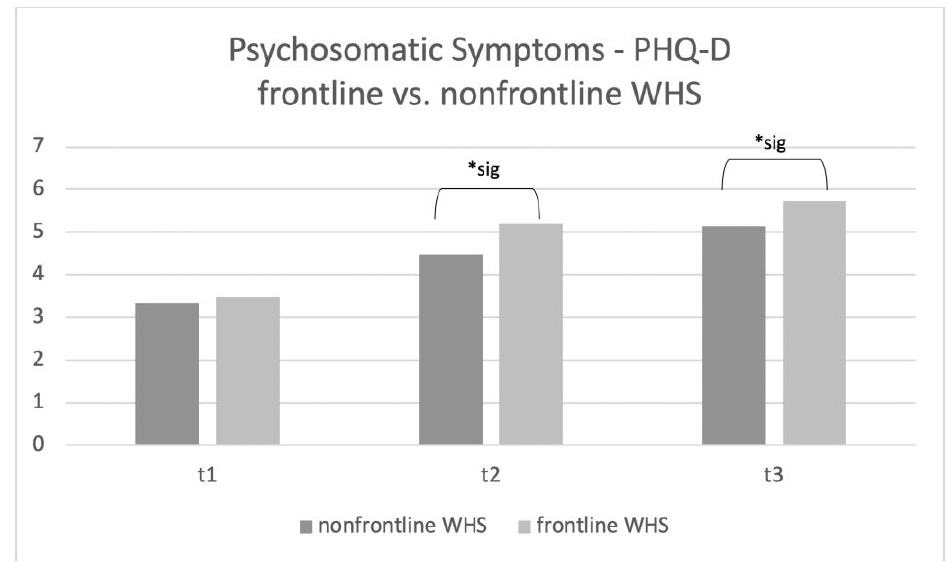
Figure 1. Patient Health Questionnaire (PHQ-D) subscale “psychosomatic symptoms” main effect frontline vs. non-frontline WHS. Significant results are marked with *sig.